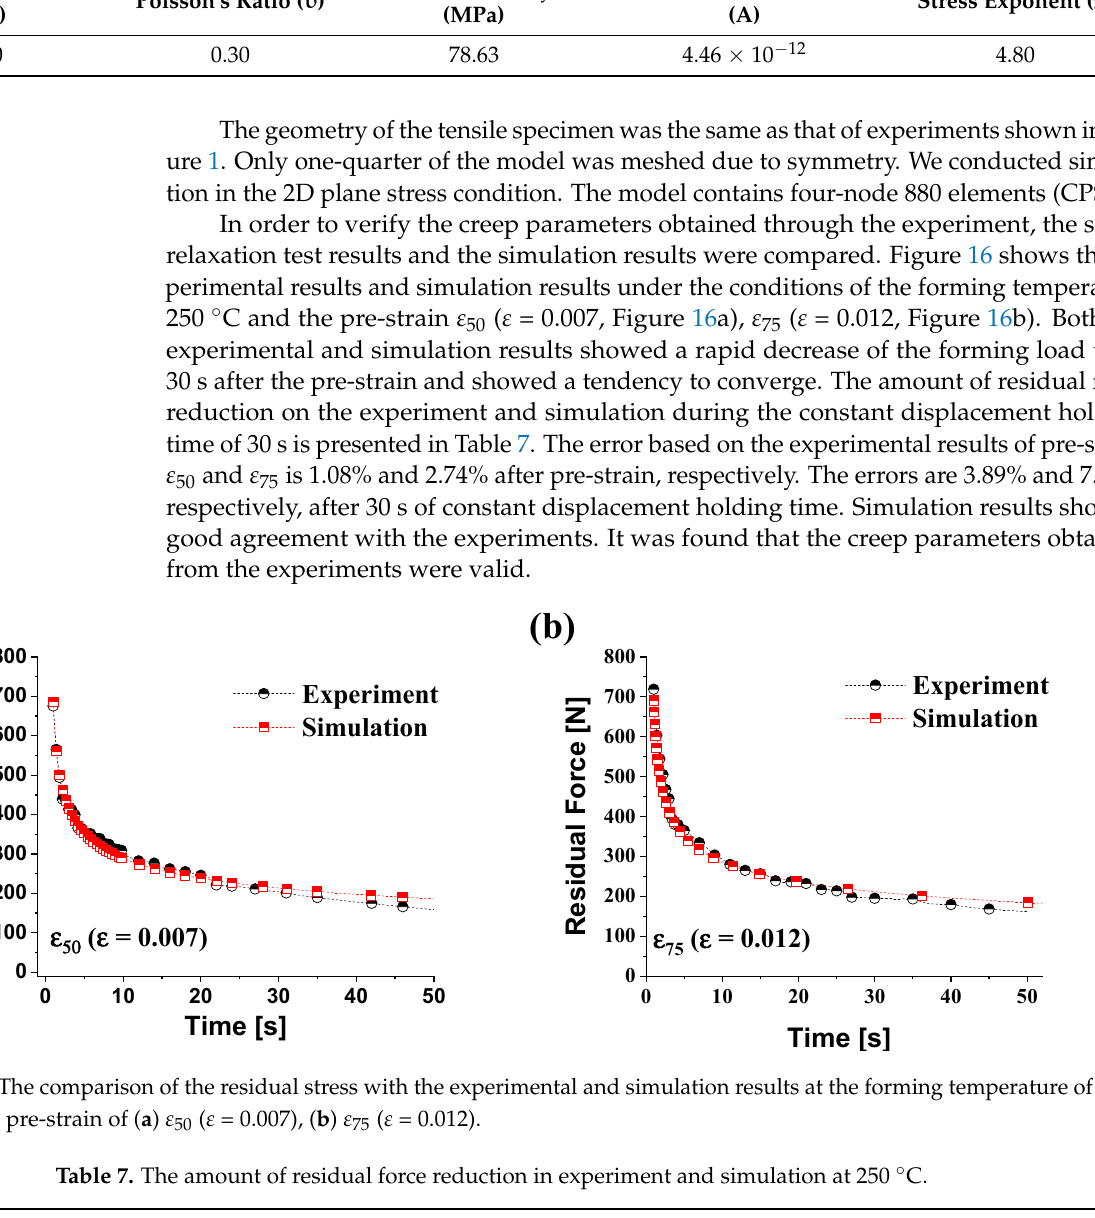
Table 6. The properties of the magnesium alloy used to the simulation at a forming temperature of 250 °C. Elastic modulus © (GPa)